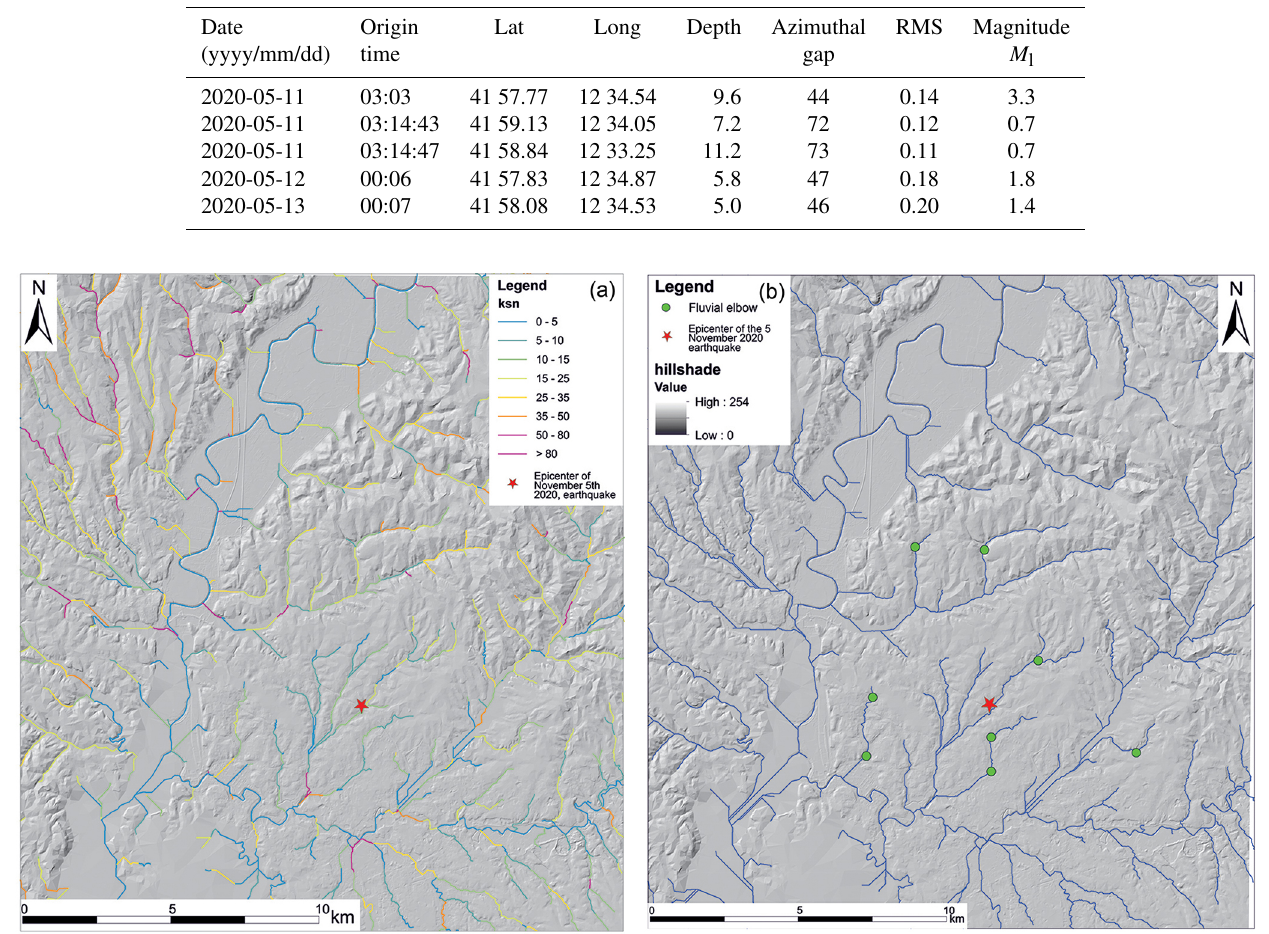
Table 2. List and localization parameters of the Roman sequence (May 2020).